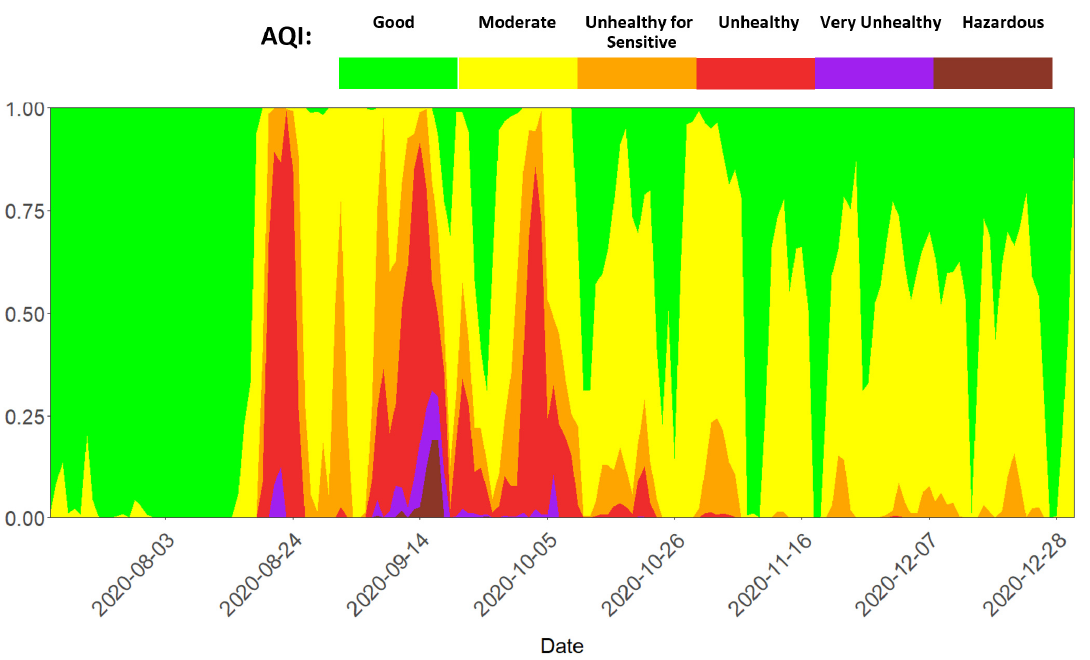
Figure 8. Percentage of the study area experiencing different AQI on each day. AQI’s are estimated based on the interpolated PM2.5.